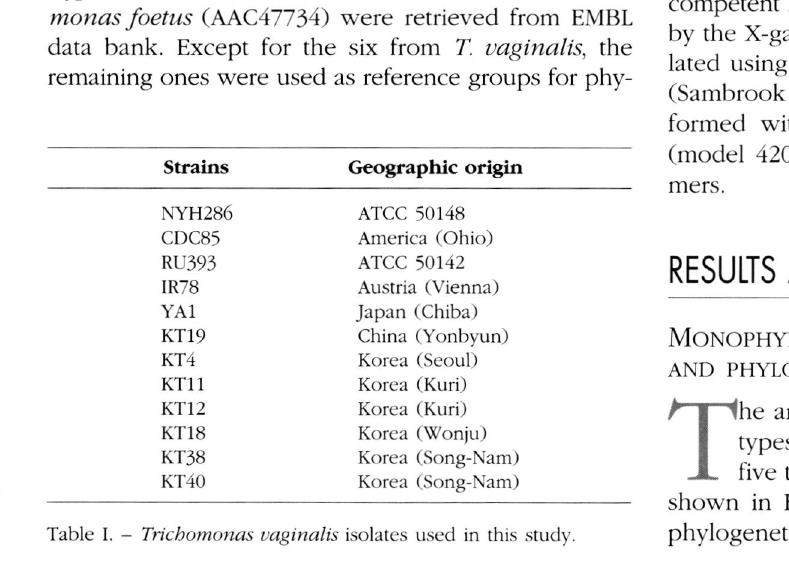
Table I. - Trichomonas vaginalis isolates used in this